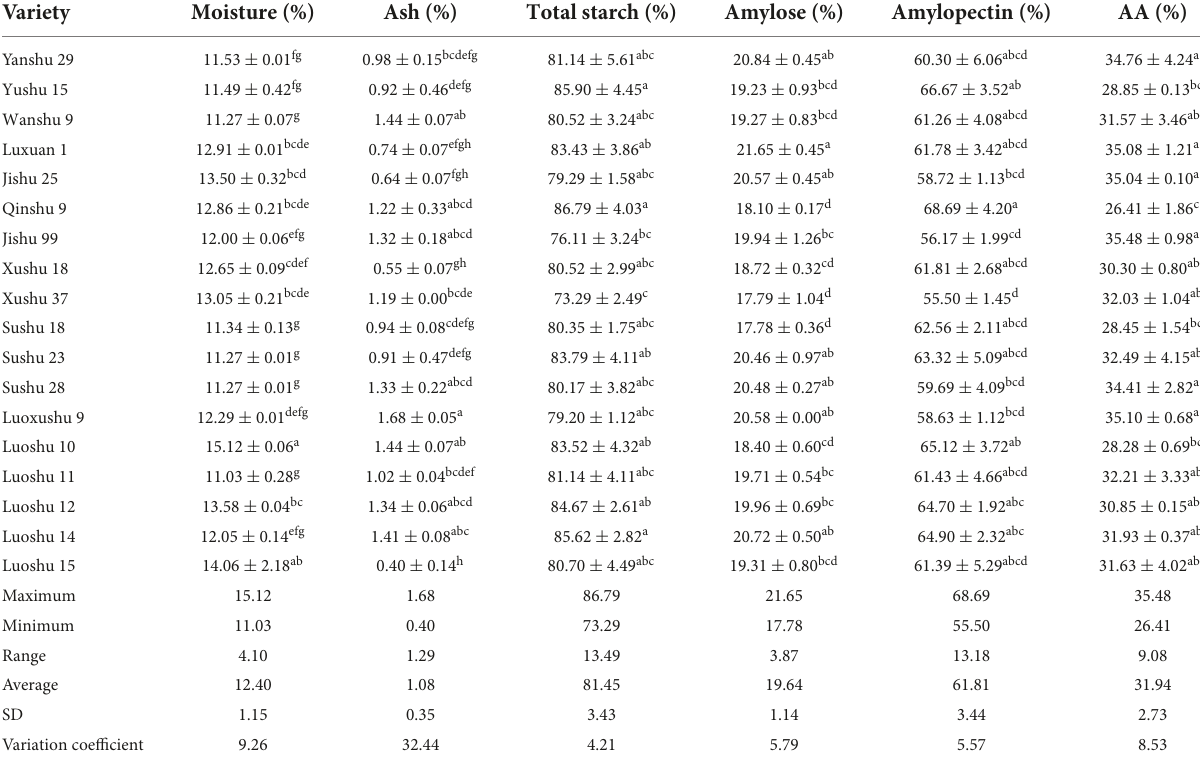
TABLE 1 Composition of sweet potato starch (wet